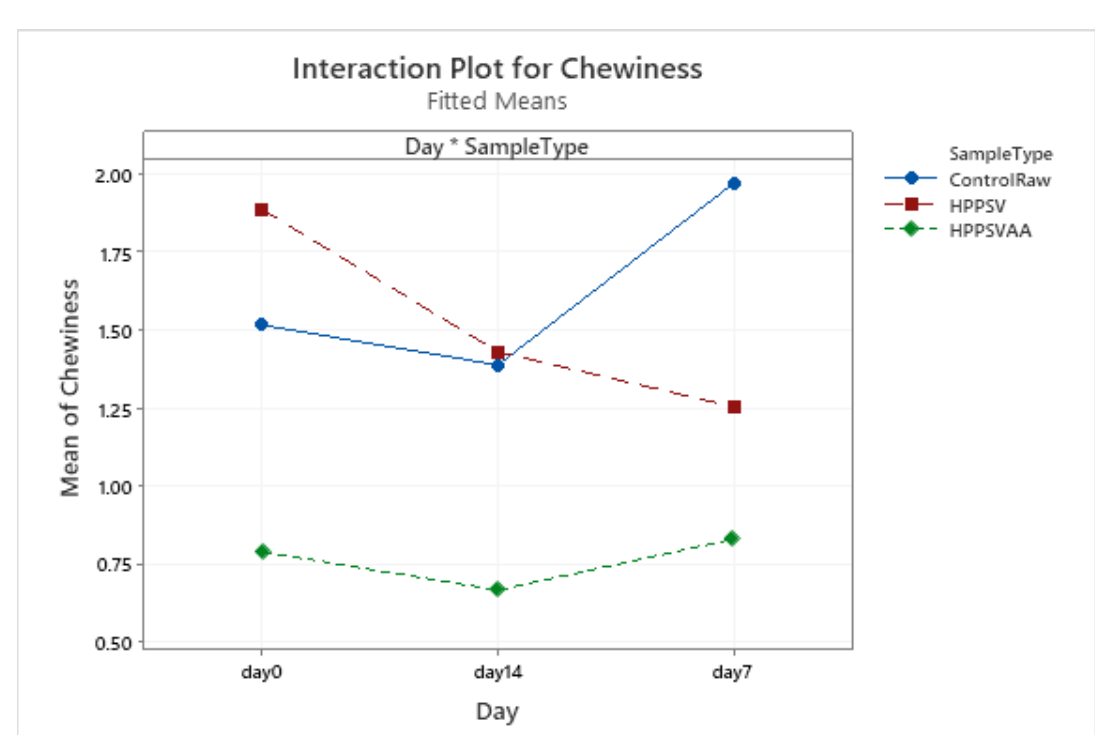
Figure A7 . Effect of treatments and storage time on the cohesiveness of plant-based patty (HPPSV: HPP-SVCOOK).